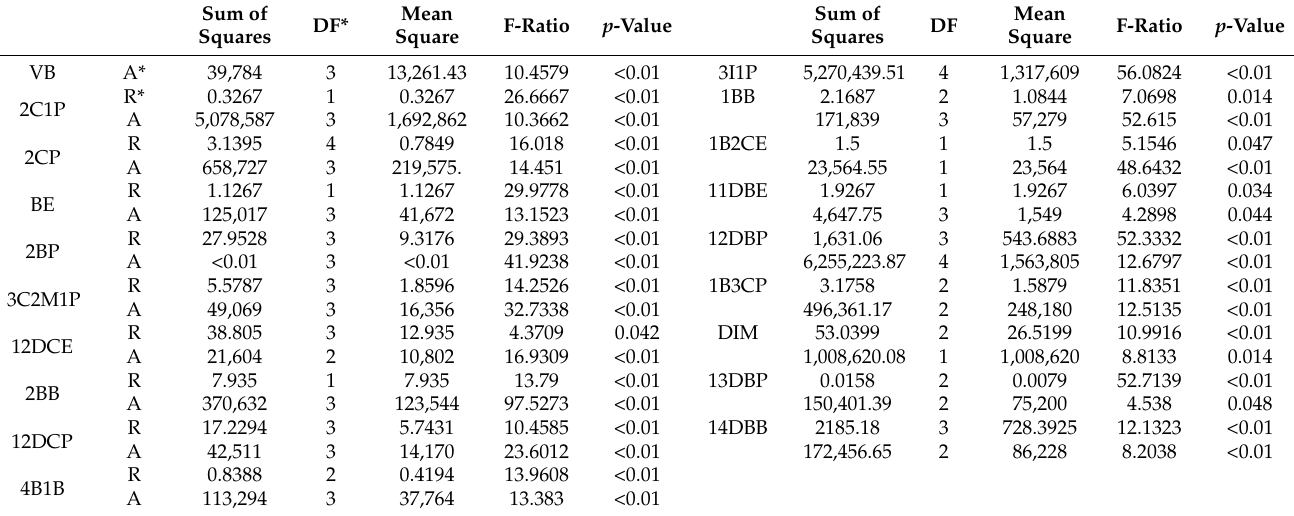
Table 5. Regression ANOVA statistics results in